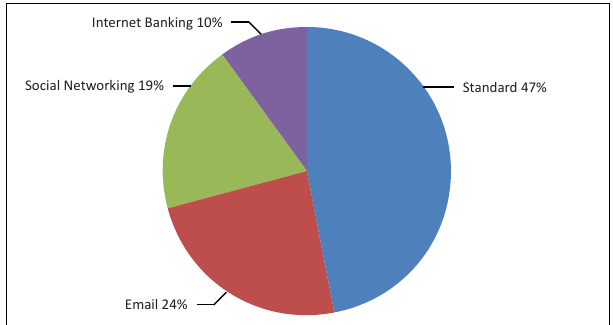
FIGURE 9: Proportional Internet